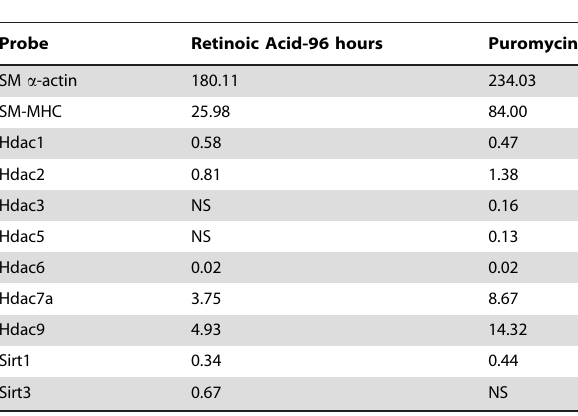
Table 1. HDAC expression with SMC differentiation.